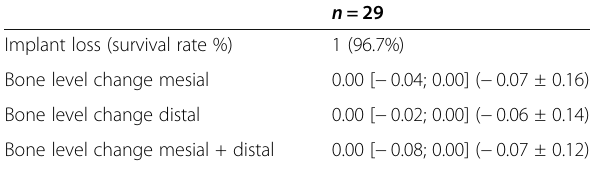
(Table 5). This score increased significantly after the de- Table 2 Survival rate (%) and bone level change from 1 month ( T 1 ) to 12 months ( T 12 ) after definitive restoration placement finitive implant restoration was placed, up to a mean measured in millimetres, with the median [IQR] and mean ± SD follow-up ( p < 0.001). score of 86.6 ± 10.3 at the T 12 depicted in the parentheses Items of function and presence of shame improved sig- n = 29 Implant loss (survival rate %) 1 (96.7%)